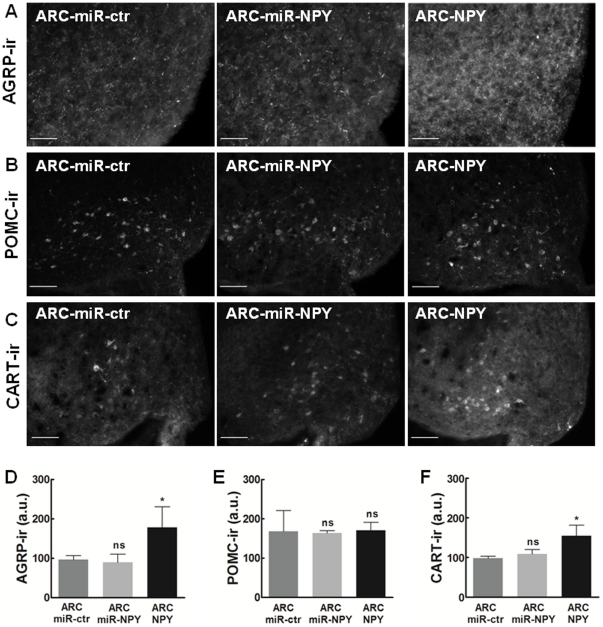
Overexpression of ARC NPY deregulates feedback mechanism in the ARC.Representative immunostaining images of ARC peptides immunoreactivity: (A) AGRP, (B) POMC and (C) CART. Bilateral quantification of ARC peptides immunoreactivity evaluated through the rostro-caudal length of the rat ARC, eight weeks after AAV injection: (D) AGRP, (E) POMC and (F) CART. Scale bar, 100 µm. n = 3/4 rats per group. ns p>0.5; * p<0.5; *** p<0.01 compared to ARC-miR-ctr. ir, immunoreactivity.